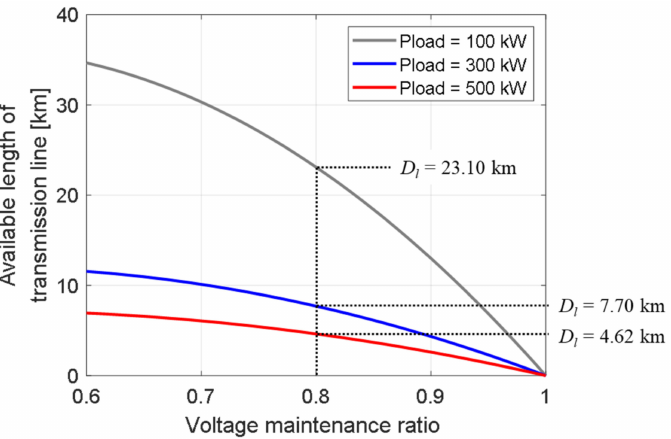
Figure 4. Available length of the transmission line according to the load